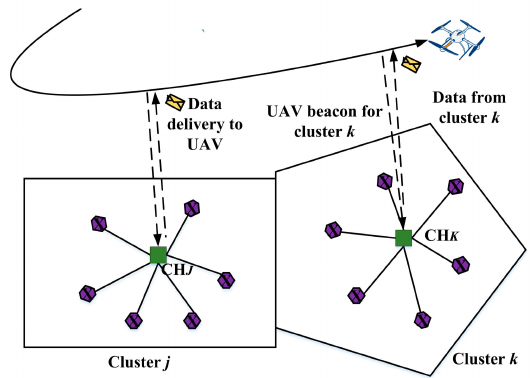
Figure 4. UAV-aided data gathering